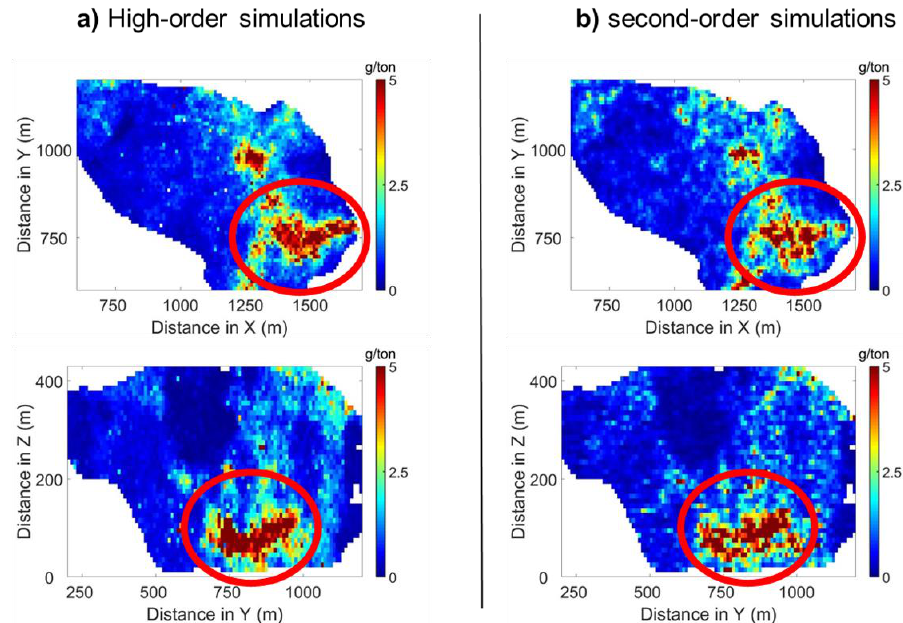
Figure 3. Cross-sections of the simulations, obtained from high-order ( a ) and second-order ( b ) based methods, highlighting differences in connectivities of high-grades. The red circles highlight the high-grade zones.